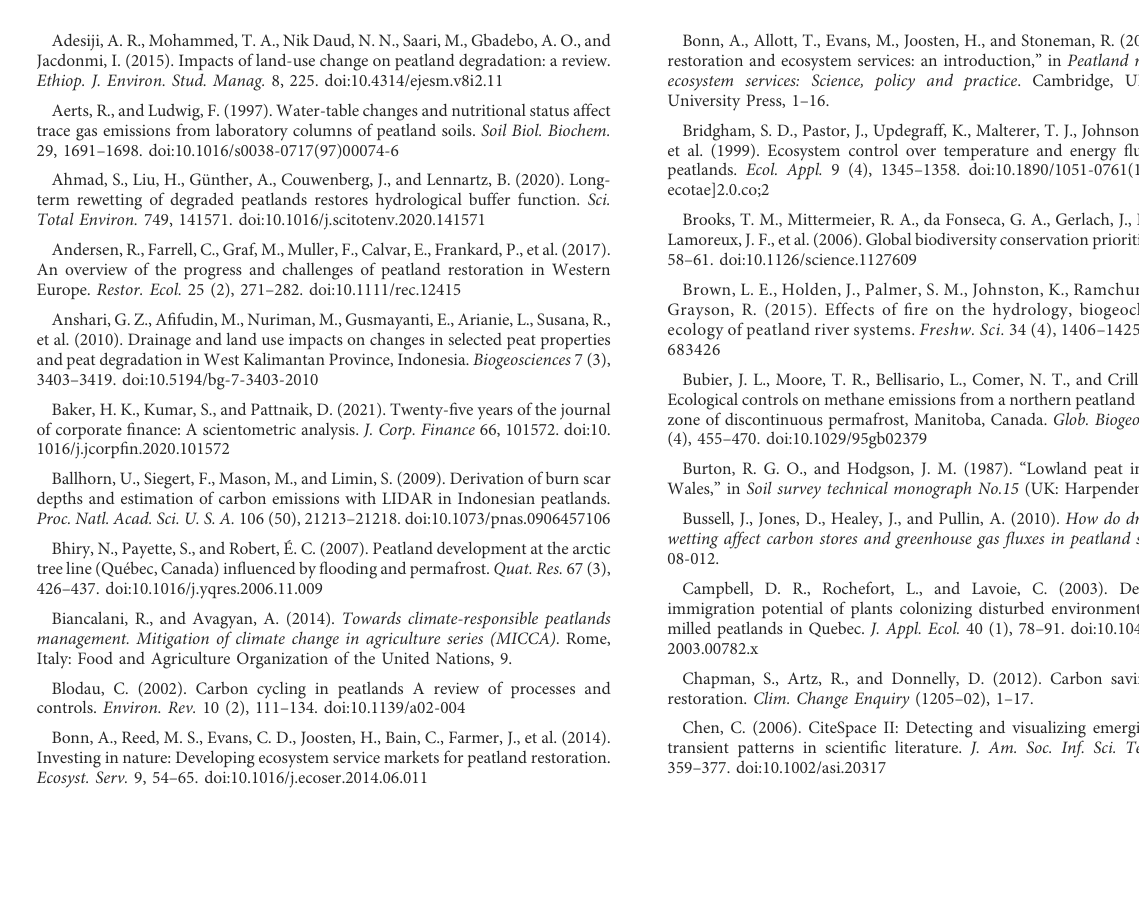
SUPPLEMENTARY FIGURE S1 Density Map of Co-Authorship Network. SUPPLEMENTARY FIGURE S2 Network of most contributing countries in the RDP